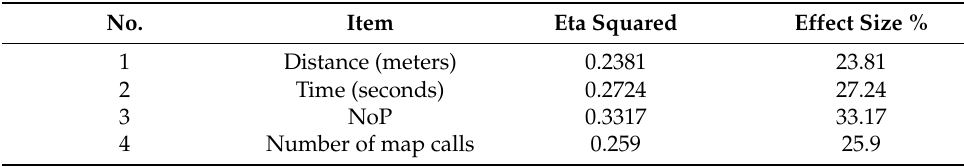
Table 5. Partial eta squared values for the size of the